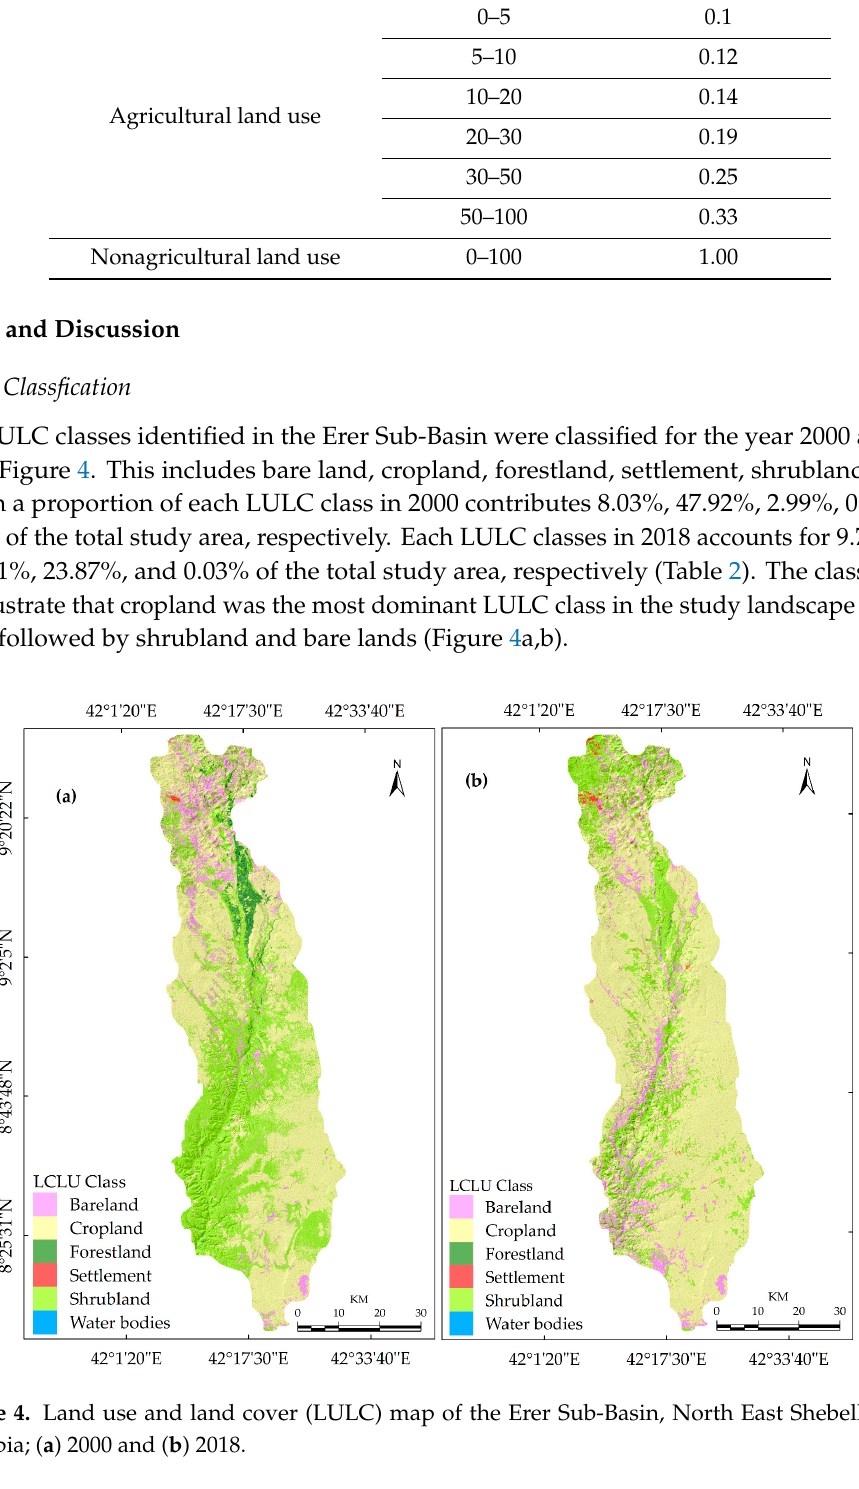
Table 2. Areal statistics of classified land use and land cover change (LULC) classes for 2000 and